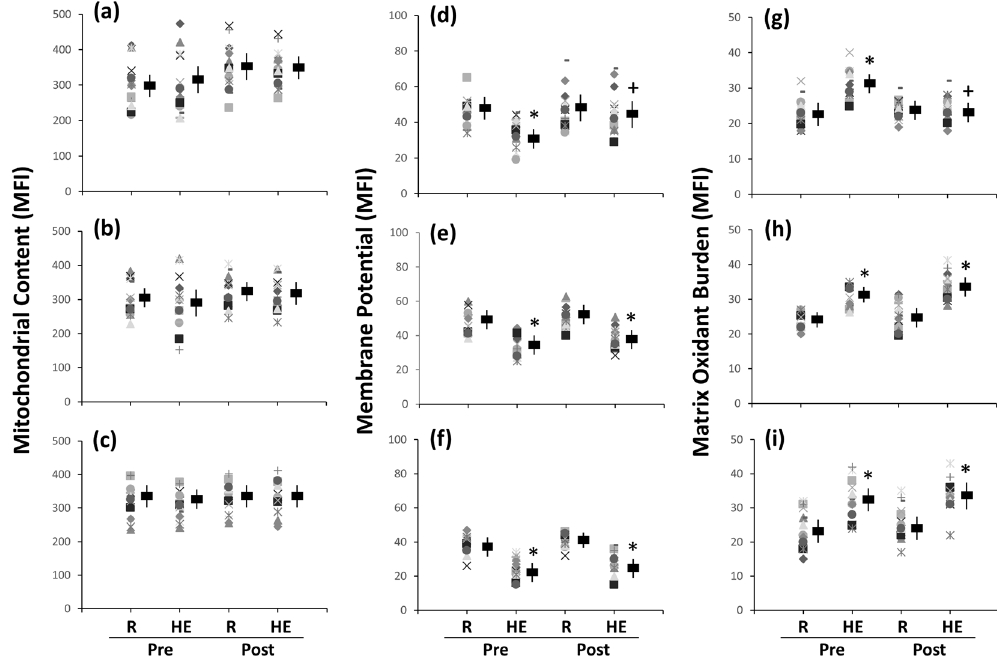
Figure 2. Effects of interval and continuous exercise regimens on (a–c) mitochondrial content, (d–f) mitochondrial membrane potential, and (g–i ) matrix oxidant burden in platelets. HIT , high-intensity interval training group (a , d , g) ; MCT , moderate-intensity continuous training (b , e , h) ; CTL , control group (c , f , i) ; Pre , pre-intervention; Post , post-intervention; R , resting; HE , hypoxic (12%O 2 ) exercise test; MFI , mean fluorescence intensity. * P < 0.05, R vs. HE ; + P < 0.05, Pre vs. Post . Values were mean ±